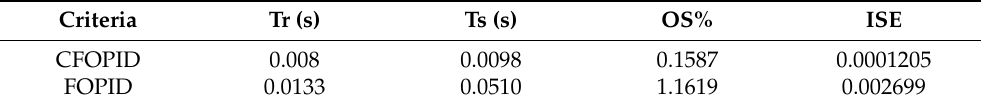
Table 5. The optimal values of the CFOPID and FOPID controllers.